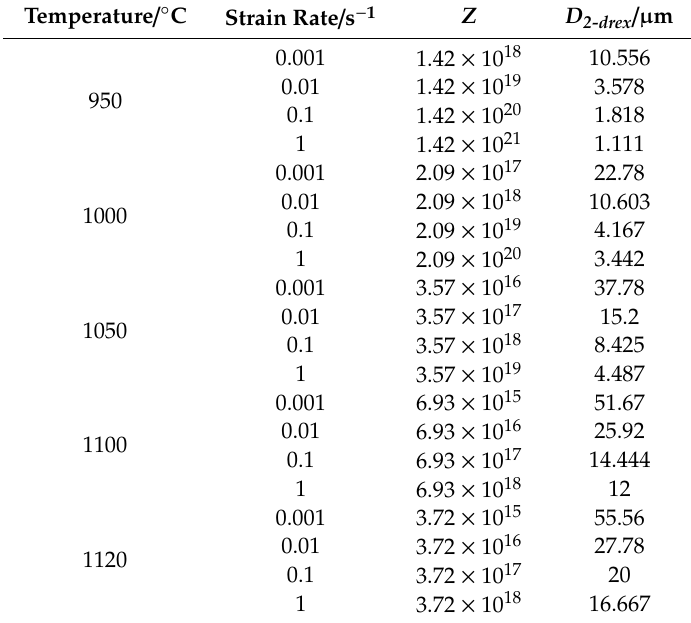
. ε Table 4. Strain rate , dynamic recrystallization grain size, and Z of the GH4169 superalloy at various temperatures.